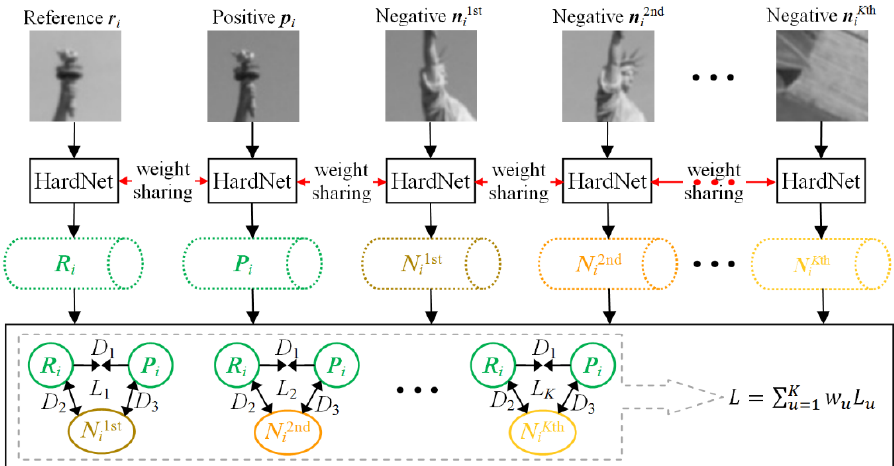
(cid:16) (cid:17) N 1st , · · · , N K th i i